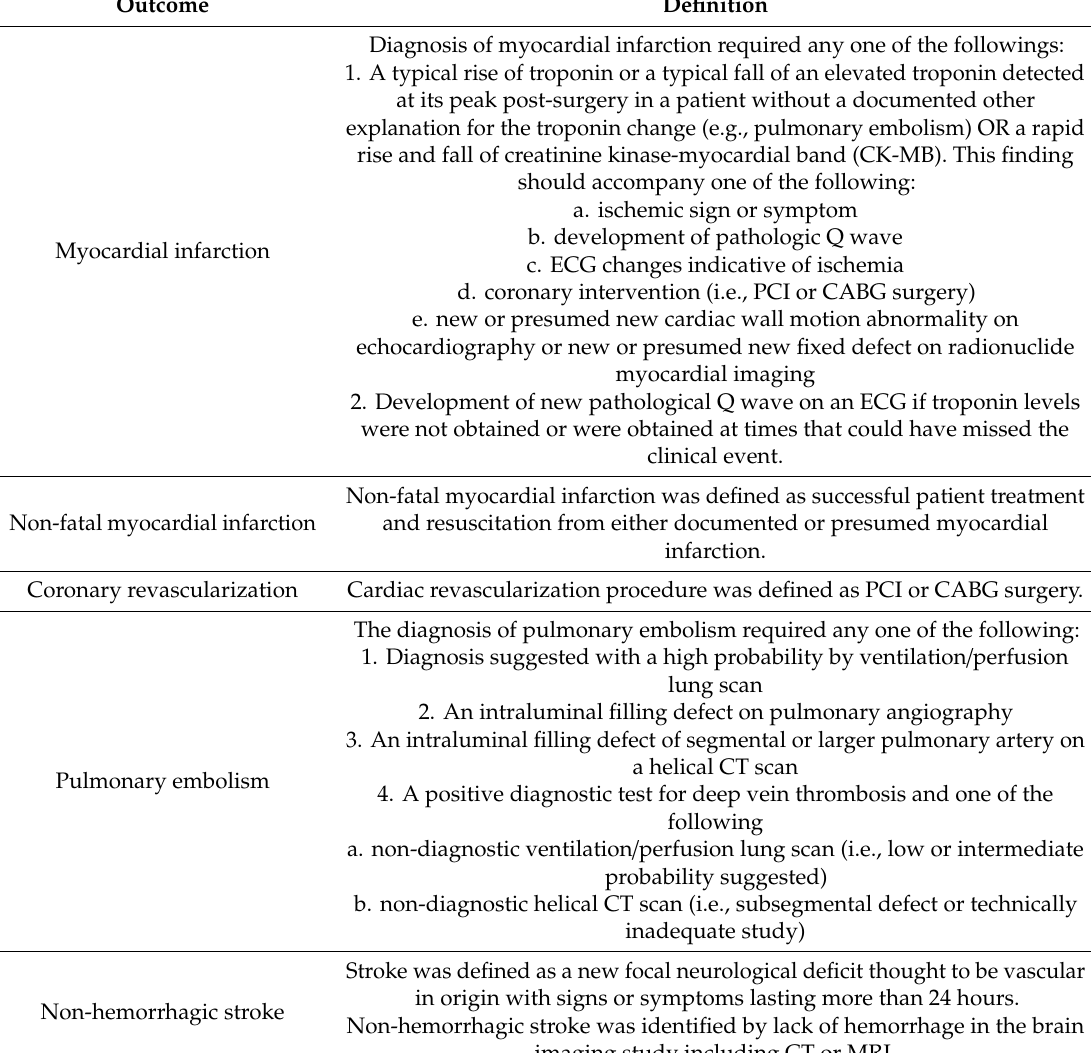
Table 2. Definitions of the components of the primary endpoint of major adverse cardiovascular and cerebral